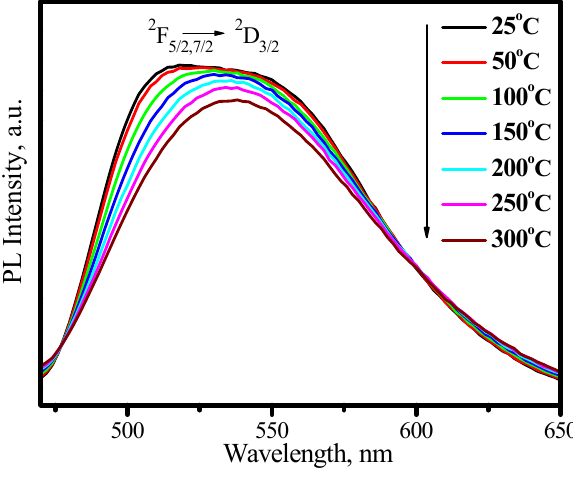
Figure 18. Emission spectra of (Lu different